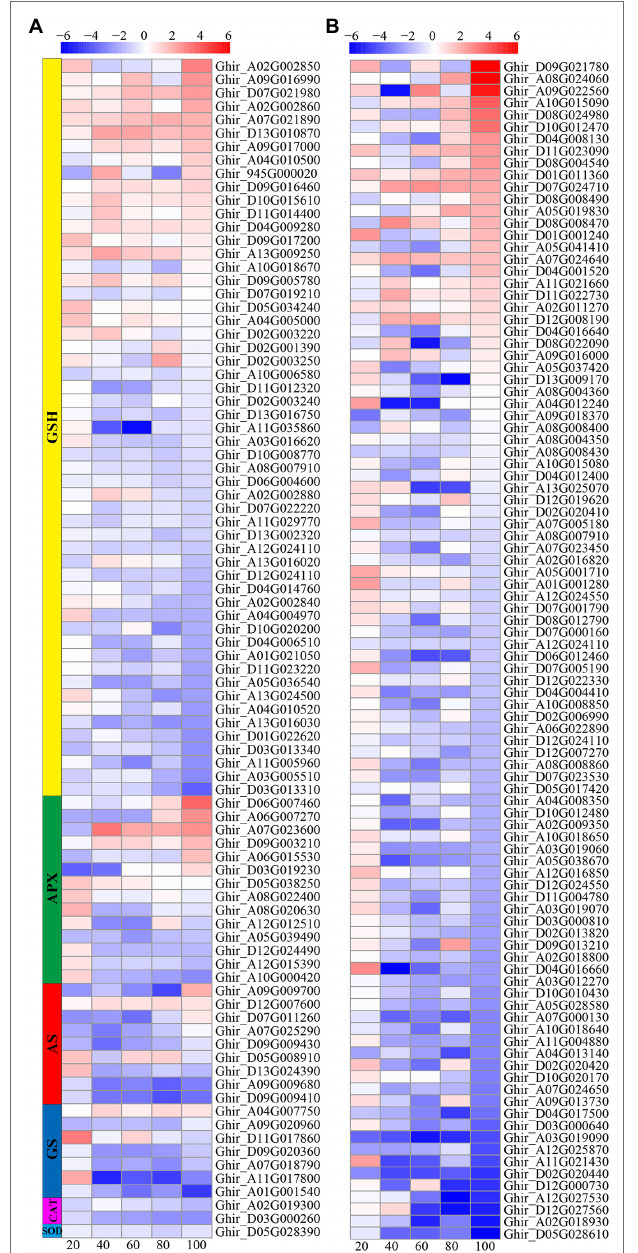
FIGURE 8 | Heat-map illustrating differential expression of glutathione (GSH), ascorbate peroxidase (APX), asparagine synthetase (AS), glutathione synthetase (GS), CAT, and SOD (A) , and POD (B) at 20, 40, 60, 80, and 100 days after emergence. Different scale color represents the size of log 2 fold change